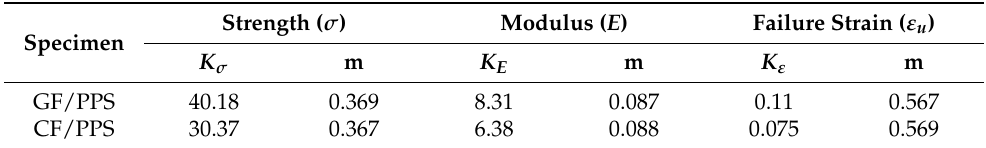
Table 2. Parameters of strain rate dependence on dynamic compression properties for GF/PPS and GF/PPS